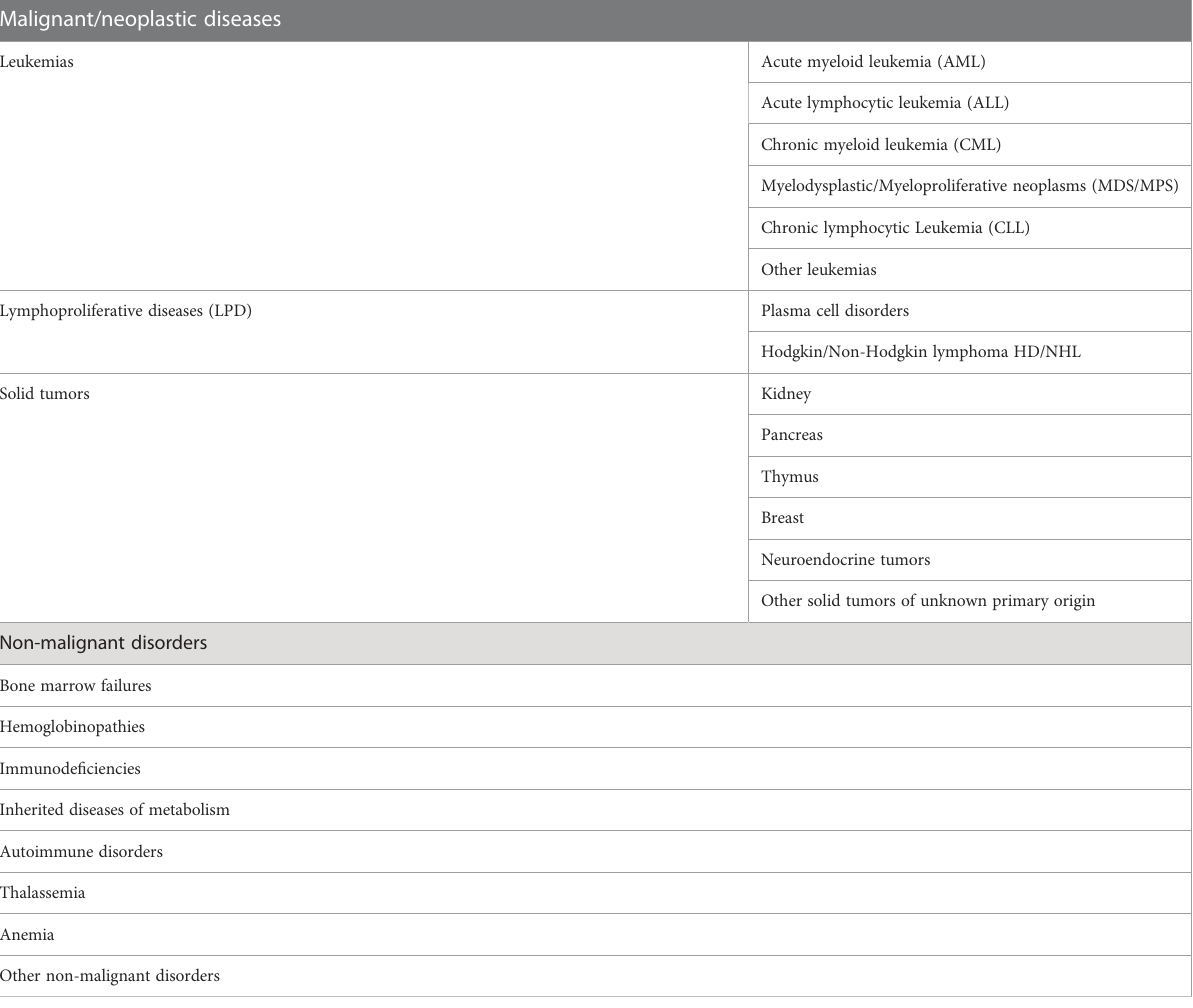
TABLE 1 Conditions for which patients may undergo